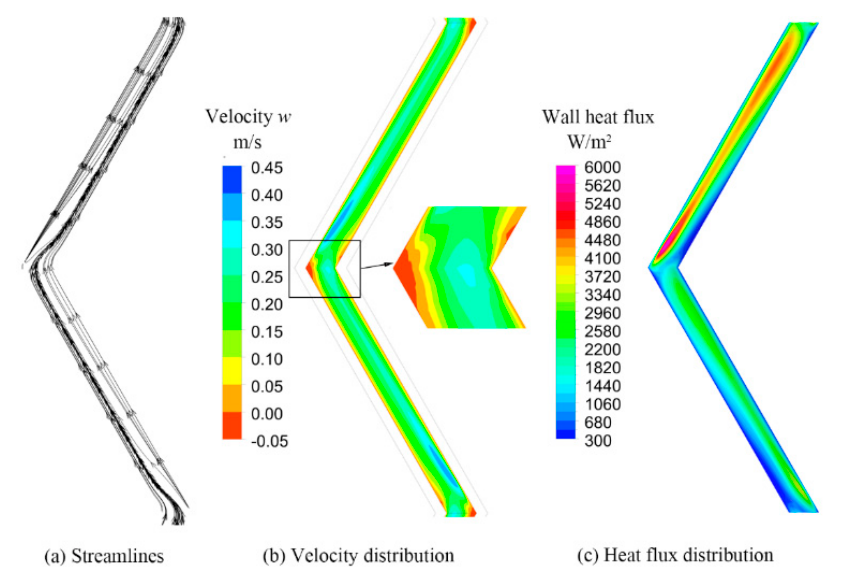
Figure 10. Flow and heat flux distribution of hot side in the third pitch.